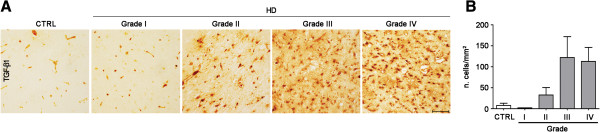
Number of TGF-β1-producing cells in post-mortem brain tissues increased with pathological grade in HD patients. A, Representative microphotograph showing TGF-β1 immunoreactivity on formalin-fixed and paraffin-embedded post-mortem striatal tissues from control subjects (CTRL) and HD patients at different neuropathological grades (Grade I, II, III, IV). B, Bar graph showing semi-quantitative analysis of TGF-β1 immunoreactive cells in HD brains. Data are presented as mean values ± s.d.